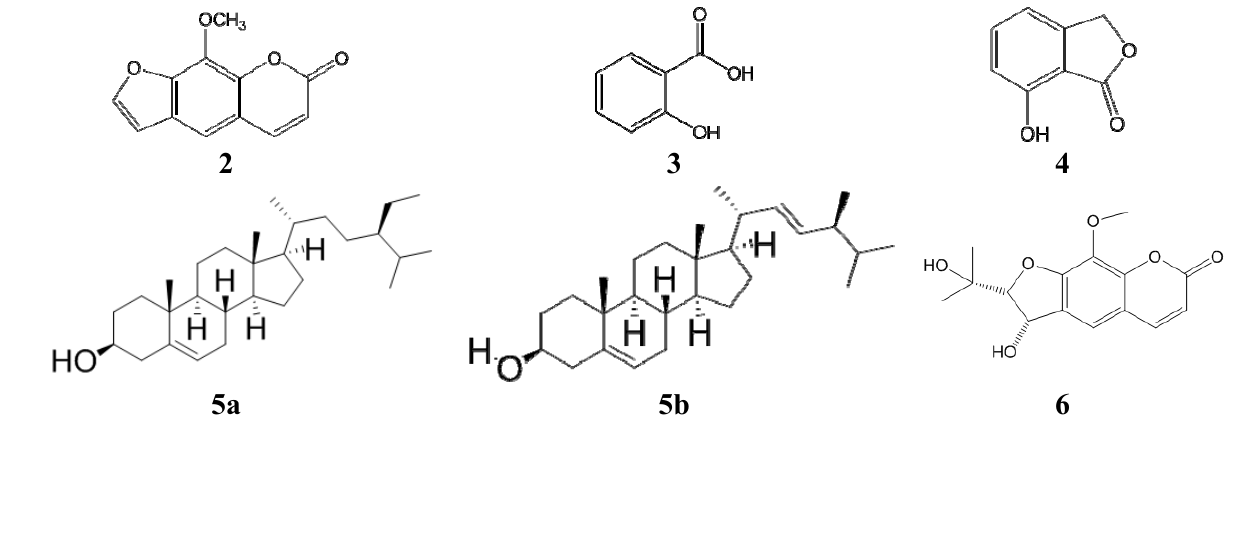
Figure 1. The structures of compounds 2 – 9 isolated from Gerbera anandria